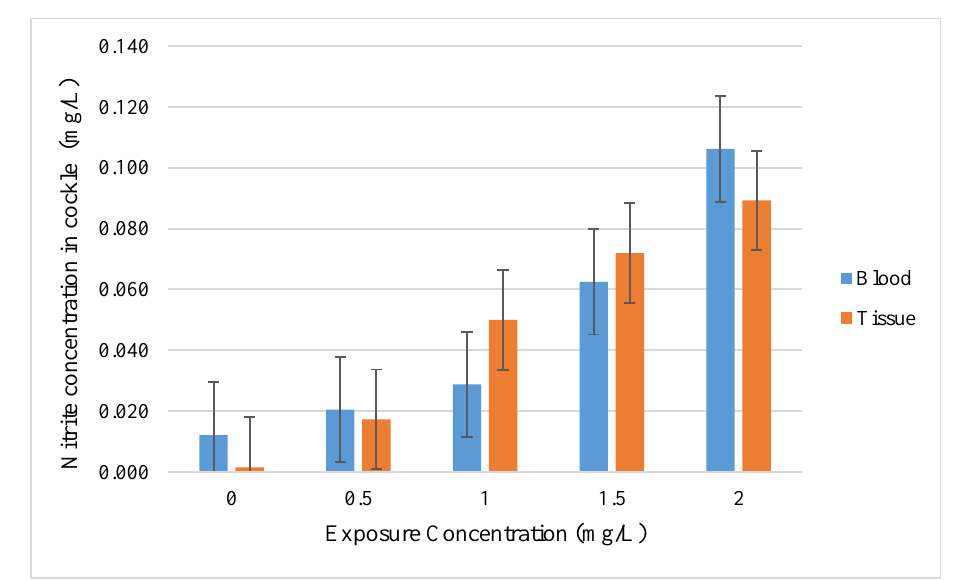
Figure 3. Mean concentration of nitrite in the blood and tissue of exposed blood cockles, with p > 0.05.